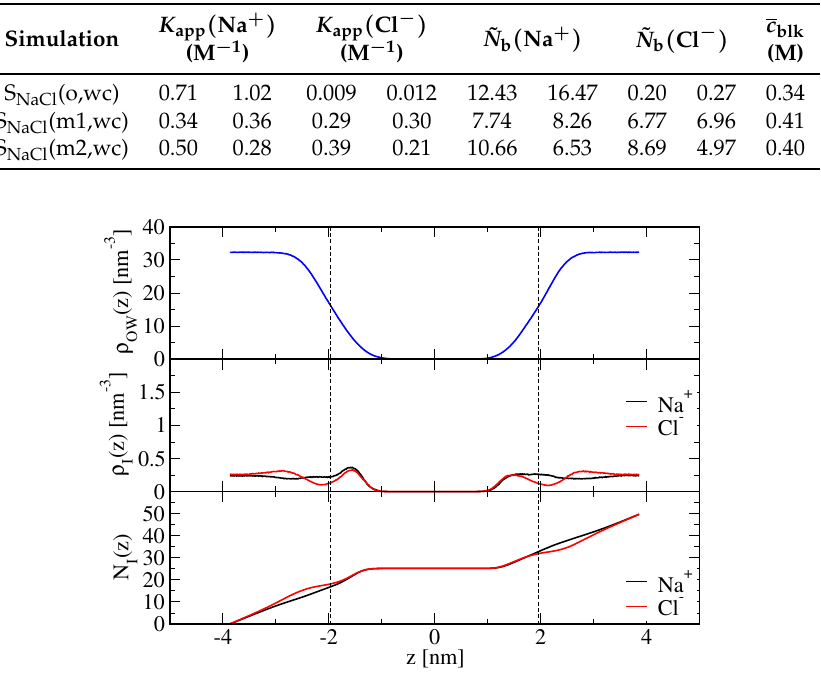
(Table 3). The first-shell coordination number of sodium ions with carbonyl- and